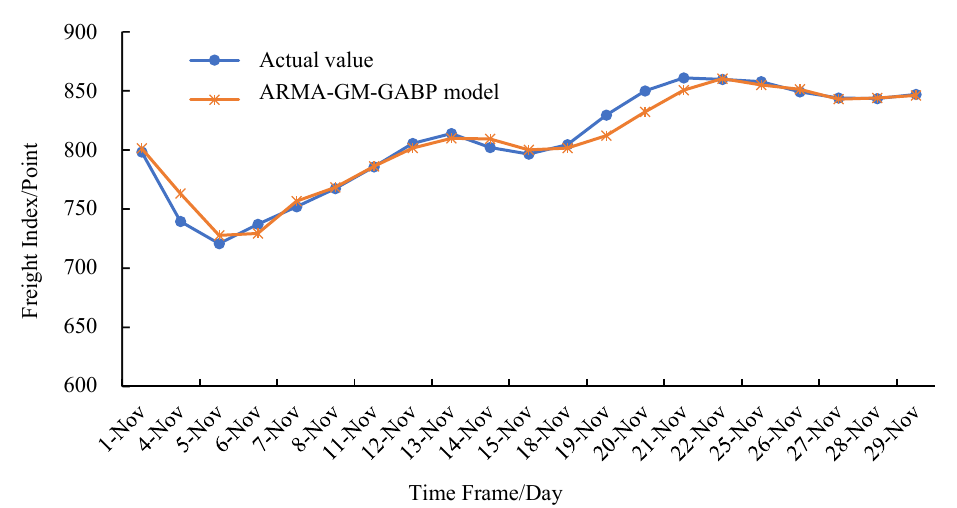
Figure 5. Comparison between forecasting result of GM model and real value.